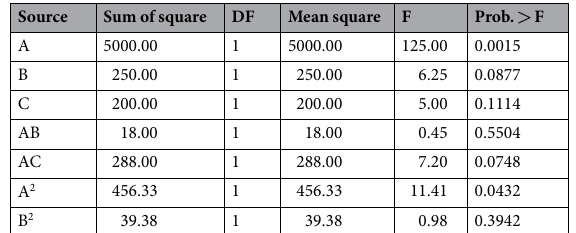
Table 3. ANOVA for CA surface modified